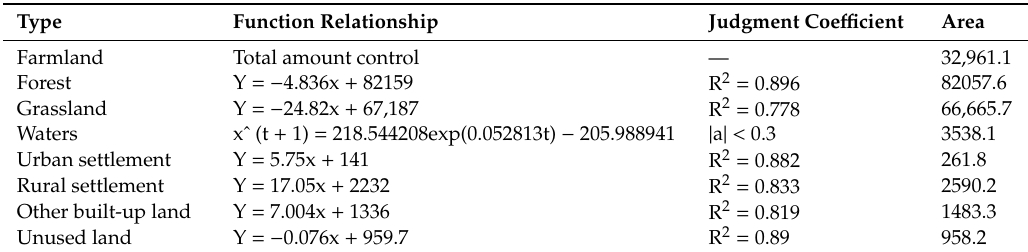
Table 4. Prediction functions, judgment coe ffi cients, and area of di ff erent land use types.